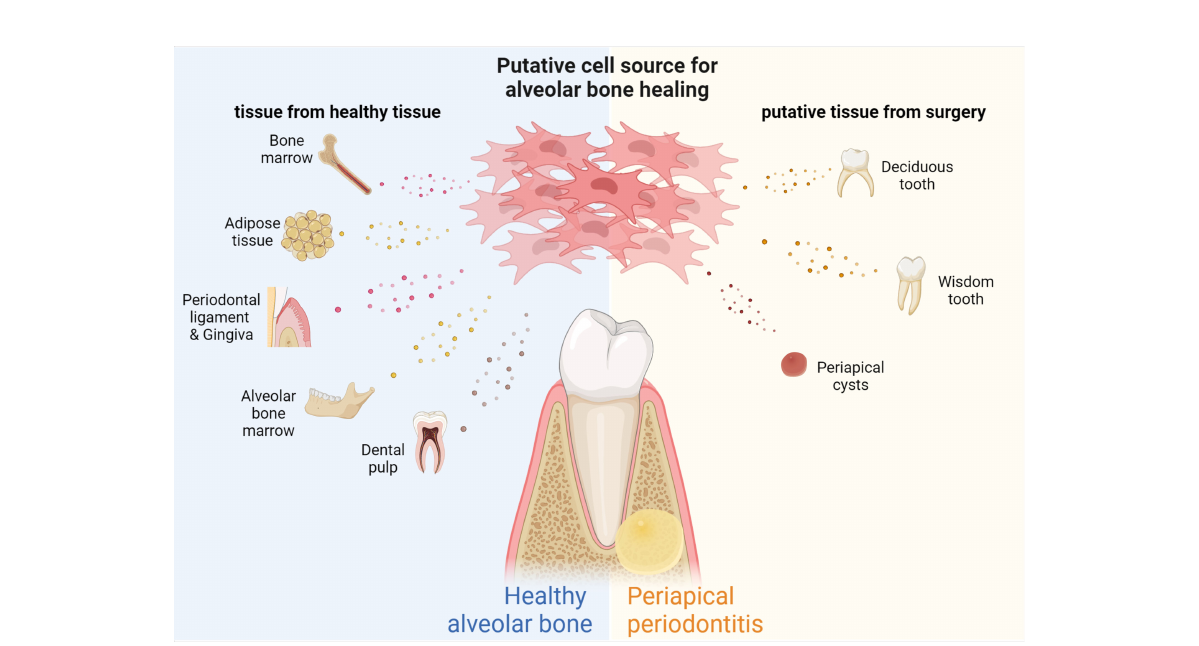
FIGURE 2 Source of MSCs for bone regeneration in periapical periodontitis. MSCs with different properties can be extracted from different tissues of the human body, including SCAPs and DPSCs from teeth, PDLSCs and GMSCs from periodontal tissue, BMSCs from bone marrow, ABMSCs and MSCs from alveolar bone, and ADSCs from adipose tissue, human milk teeth, apical cysts, while wisdom teeth can also be used as biomaterials for obtaining